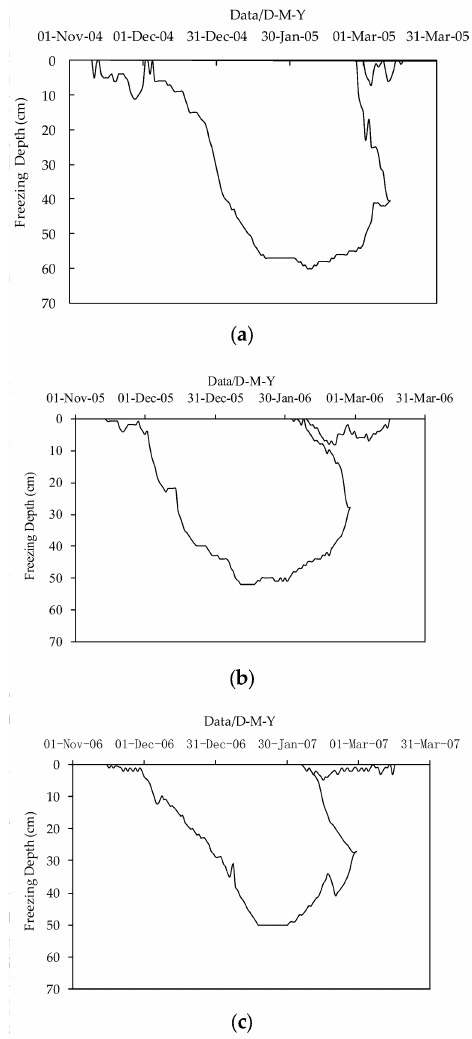
Figure 3. The soil freezing and thawing process at the experimental station during the three successive freeze–thaw periods ( a ) from 2004 to 2005; ( b ) from 2005 to 2006; and ( c ) from 2006 to